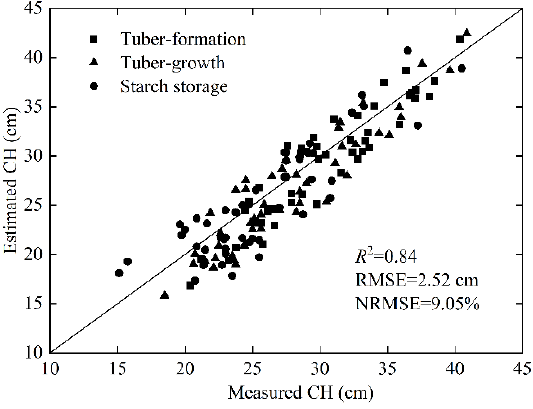
Figure 2. Measured and estimated potato